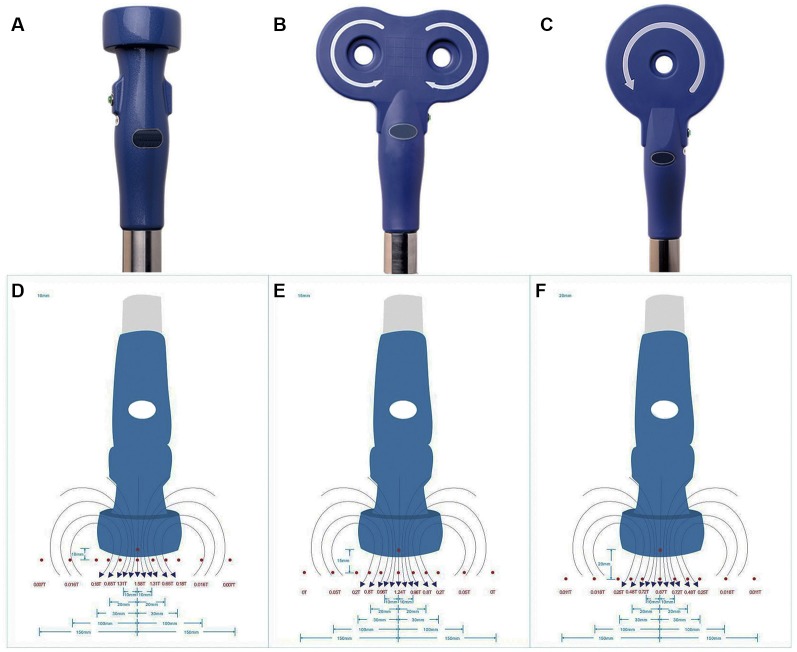
Appearance of stimulation coil and intensities of repetitive transcranial magnetic stimulation (rTMS). Appearance of experimental coil (A), figure-8 coil (B) and circular coil (C). Schematic diagram of different intensities of rTMS were measured at 1.0 cm (D), 1.5 cm (E) and 2.0 cm (F) from the center of the coil to the bottom of the culture dish.